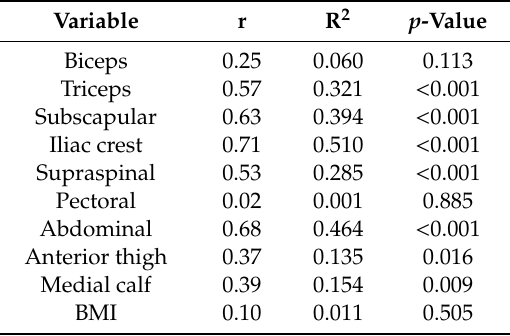
Table3. RelationshipsbetweenDXA-derivedFM%anddi ff erentskinfoldsmeasuredintheinternational- level elite